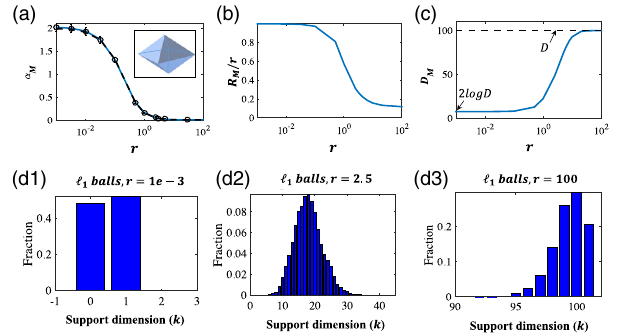
FIG. 9. Separability of l 1 balls. (a) Linear classification capacity of l 1 balls as a function of radius r with D ¼ 100 and N ¼ 200 : MFT solution (blue lines), spherical approximation (black dashed lines), full numerical simulations (circles). Inset: Illustration of l 1 ball. (b) Manifold radius R relative to the M actual radius r . (c) Manifold dimension D as a function of r . In M the small r limit, D is approximately 2 log D , while, in large r , M D is close to D , showing how the solution is orthogonal to the M manifolds when their sizes are large. (d1) – (d3) Distribution of support dimensions: (d1) r ¼ 0 . 001 , where most manifolds are either interior or touching; (d2) r ¼ 2 . 5 , where the support dimension has a peaked distribution; (d3) r ¼ 100 , where most manifolds are close to being fully